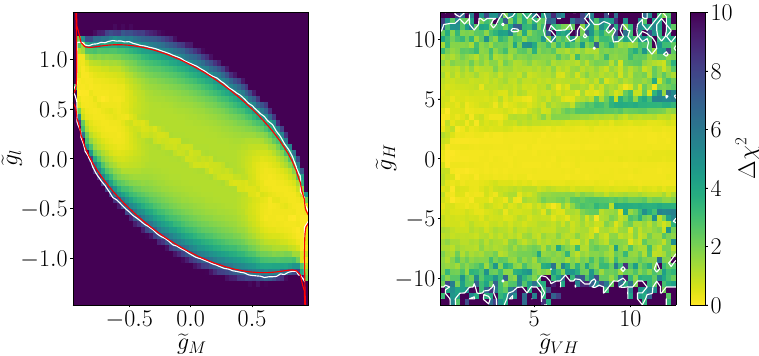
Figure 10: Heat map of the profiled ∆ χ 2 distribution from the same fit as in Fig. 9, with 1-loop matching and profiling over the matching scale. The red con- / Λ 2 = − 0.014, + 0.017 TeV − 2 and the white contours indicate tours indicate f LLLL ∆ χ 2 =